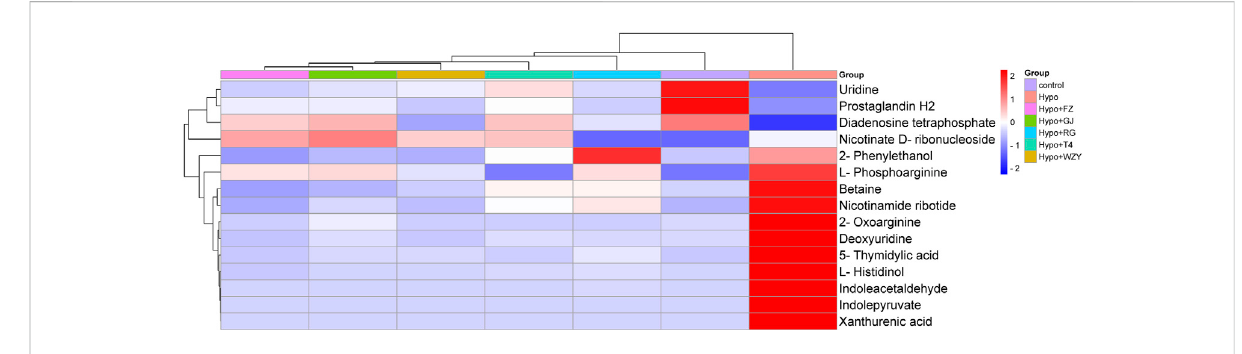
FIGURE 6 The heat map and cluster analysis for the potential